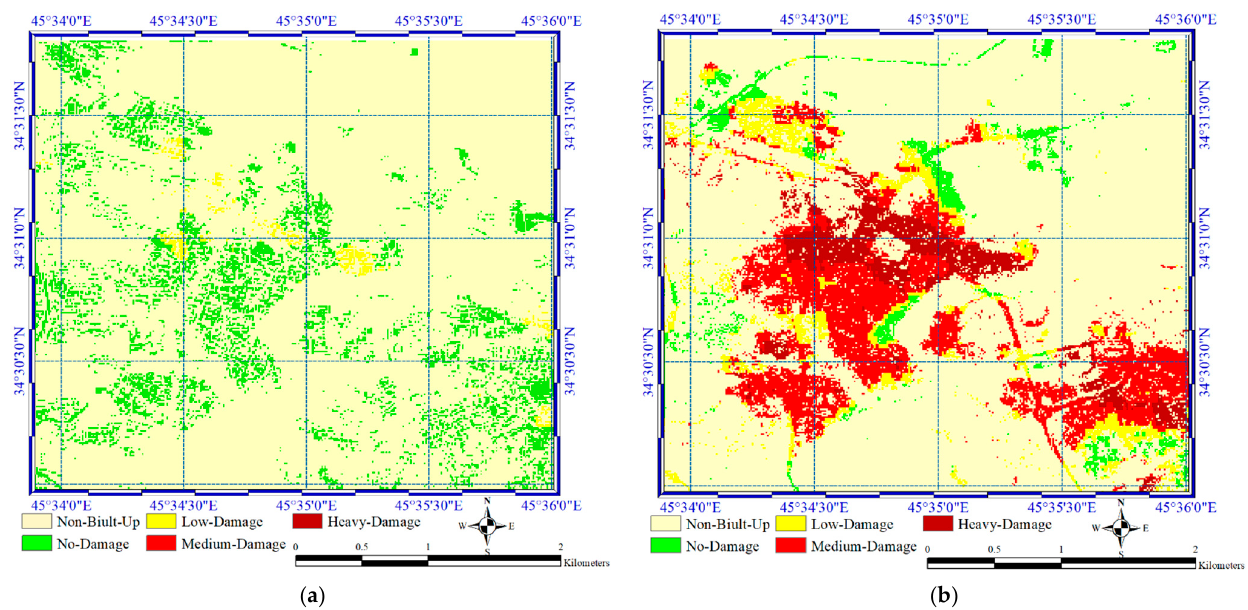
Figure 9. The result of damage detection on both datasets. ( a ) The ND-Based method in Qasr-Shirin, and ( b ) Proposed method in Qasr-Shirin.